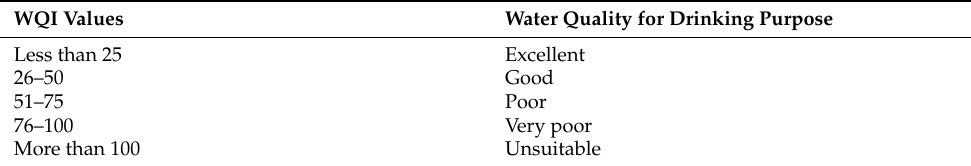
Table 2. Classification of Water Quality Index (WQI) of drinking water.